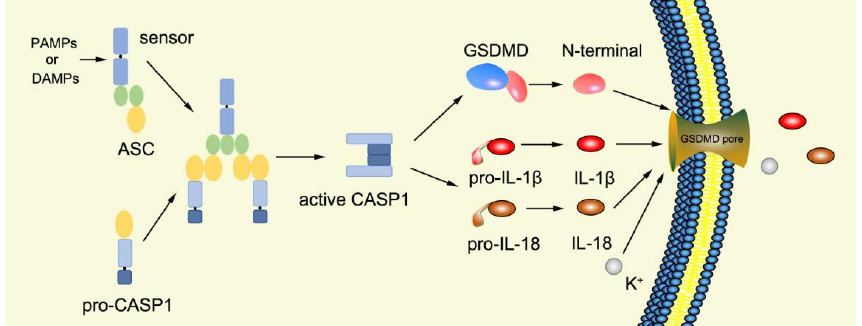
Figure 3. Mechanism of canonical pyroptosis pathway.